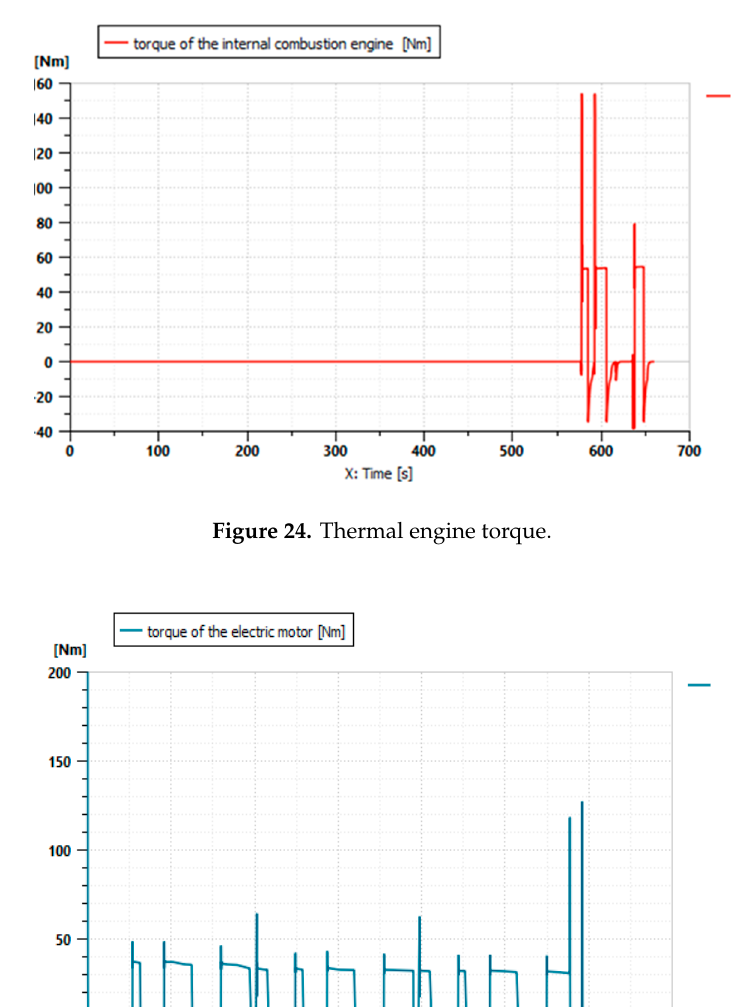
Figure 23. Tractor driving cycle with a straw tub grinder attached.